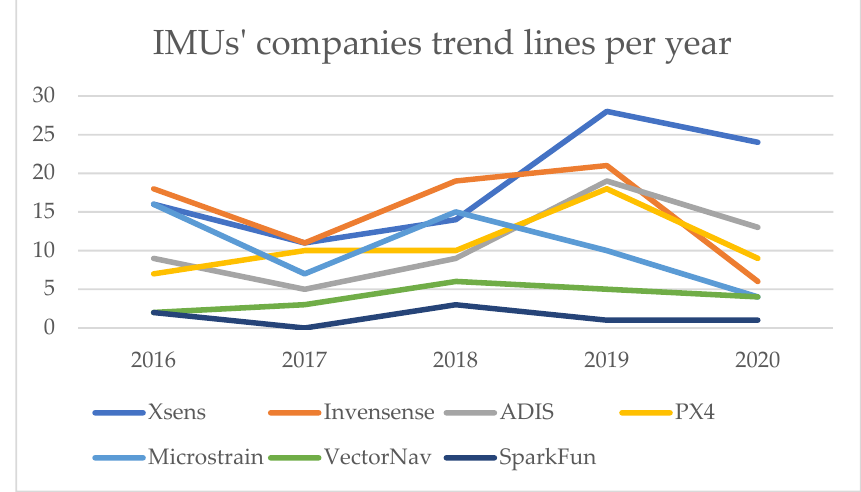
Figure 9. Trend lines of the 7 IMUs’ companies in years 2016–2020.